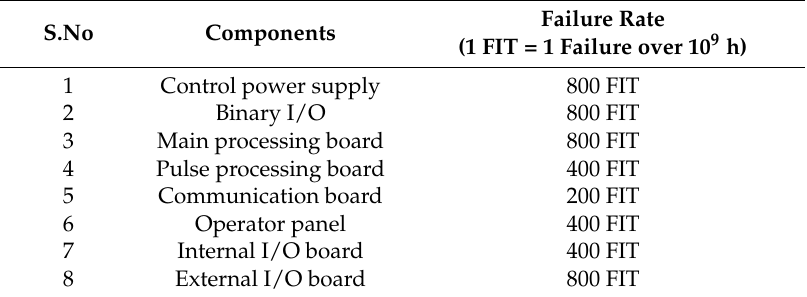
Table 6. Failure rate for control system components